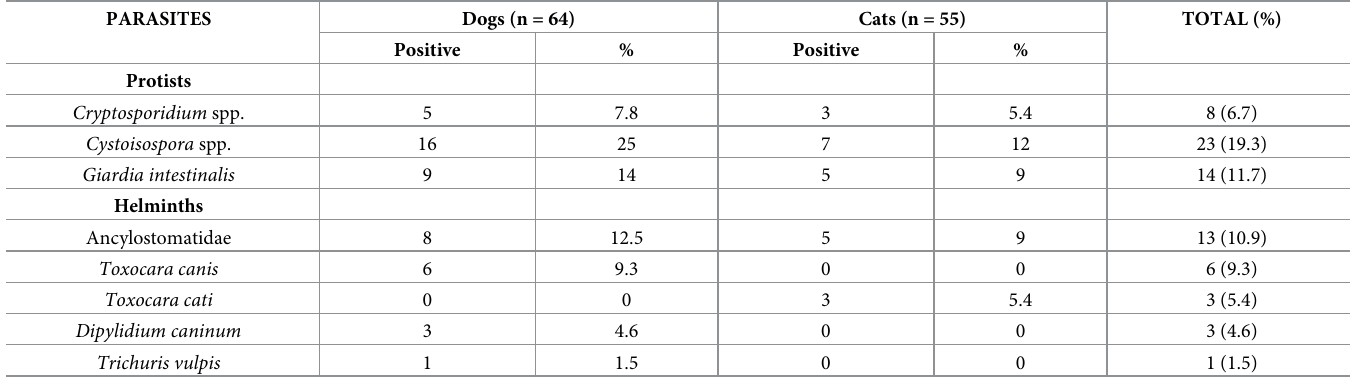
Table 2. Prevalence of gastrointestinal infections in fecal samples from 119 dogs and cats in the neighborhood of Campo Grande, Rio de Janeiro, Brazil. PARASITES